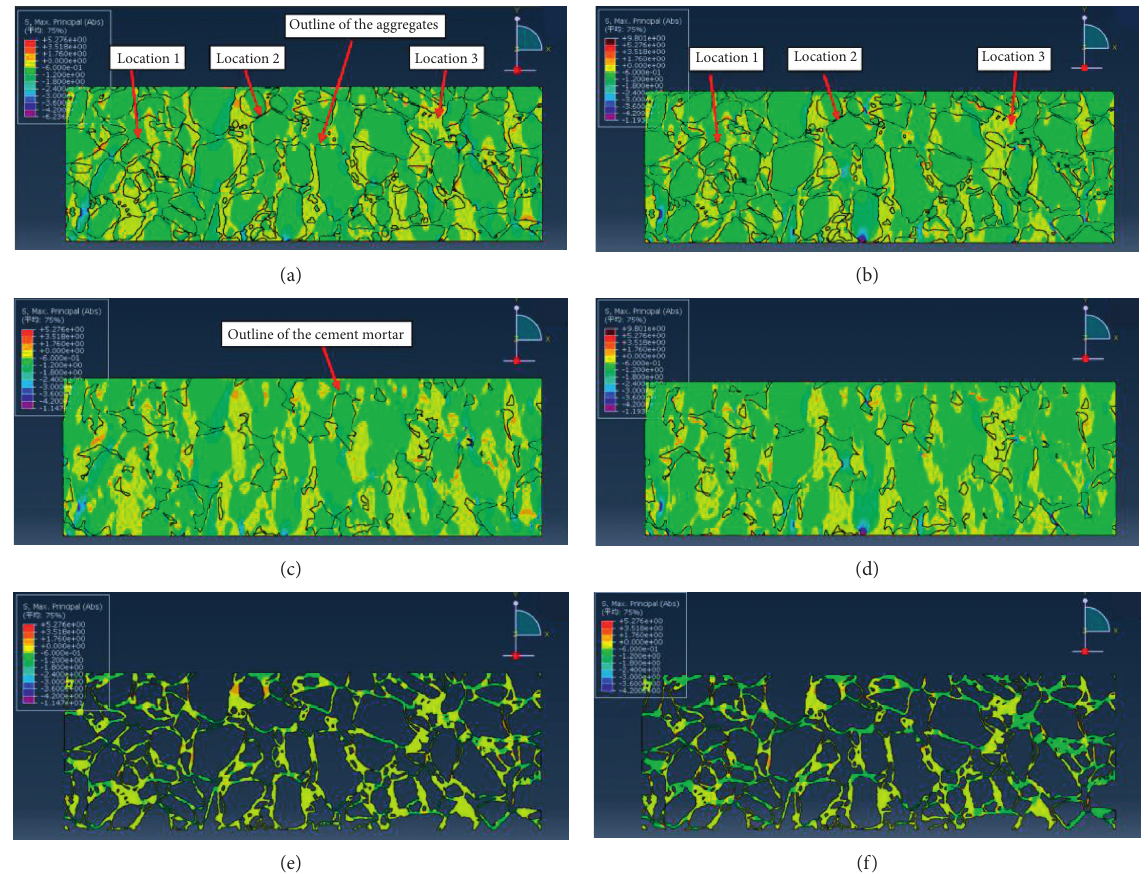
Figure 7: Stress nephogram: (a) aggregates outline with interface; (b) aggregates outline without interface; (c) cement mortar outline with interface; (d) cement mortar outline without interface; (e) asphalt mastic with interface; (f) asphalt mastic without interface.